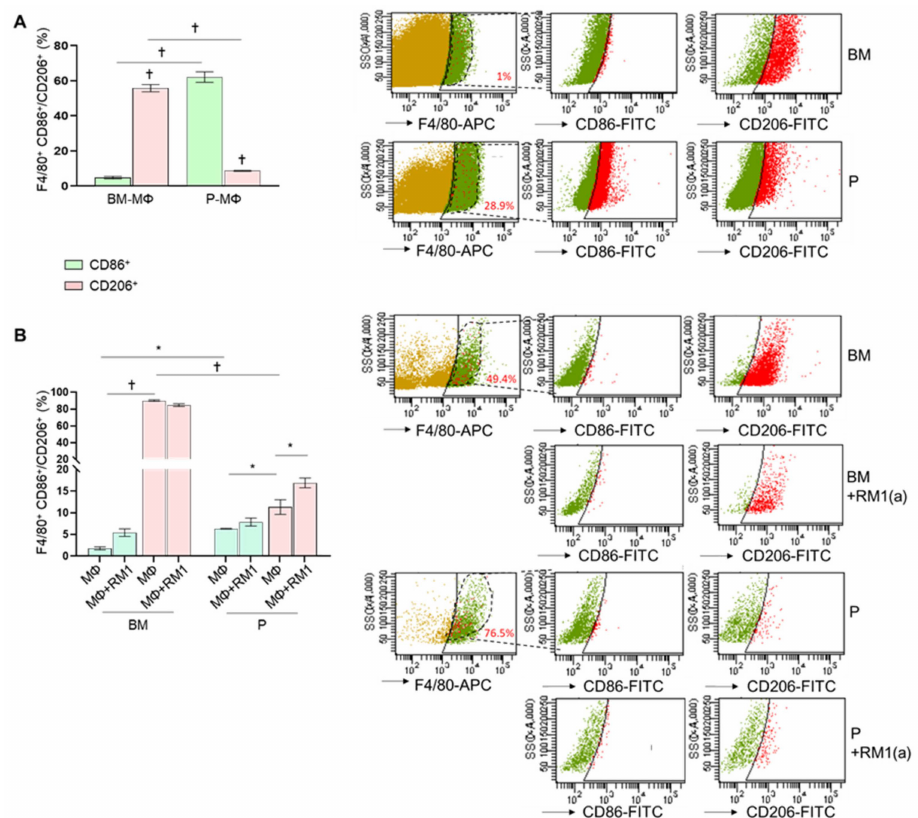
Figure 2. Ex vivo and in vitro M1 and M2 polarization of bone marrow-derived and peritoneal macrophages. BM-M Φ sandP-M Φ swereisolatedfromC57BL / 6Jmice. ( A )Freshlyisolatedbonemarrow and peritoneal exudate cells were stained for anti-F4 / 80-APC combined with either anti-CD86-FITC or anti-CD206-FITC and analyzed by flow cytometry. ( B ) BM-M Φ s and P-M Φ s co-cultured with RM1(a) cells for 18 h were stained with anti-F4 / 80-APC combined with either anti-CD86-FITC or anti-CD206-FITC and analyzed by flow cytometry. BM, bone marrow; P, peritoneal. Data in A and B are mean ± SEM, n = 3 per group; * p < 0.05, † p < 0.0001 (one-way ANOVA; Dunnet’s multiple-comparisons